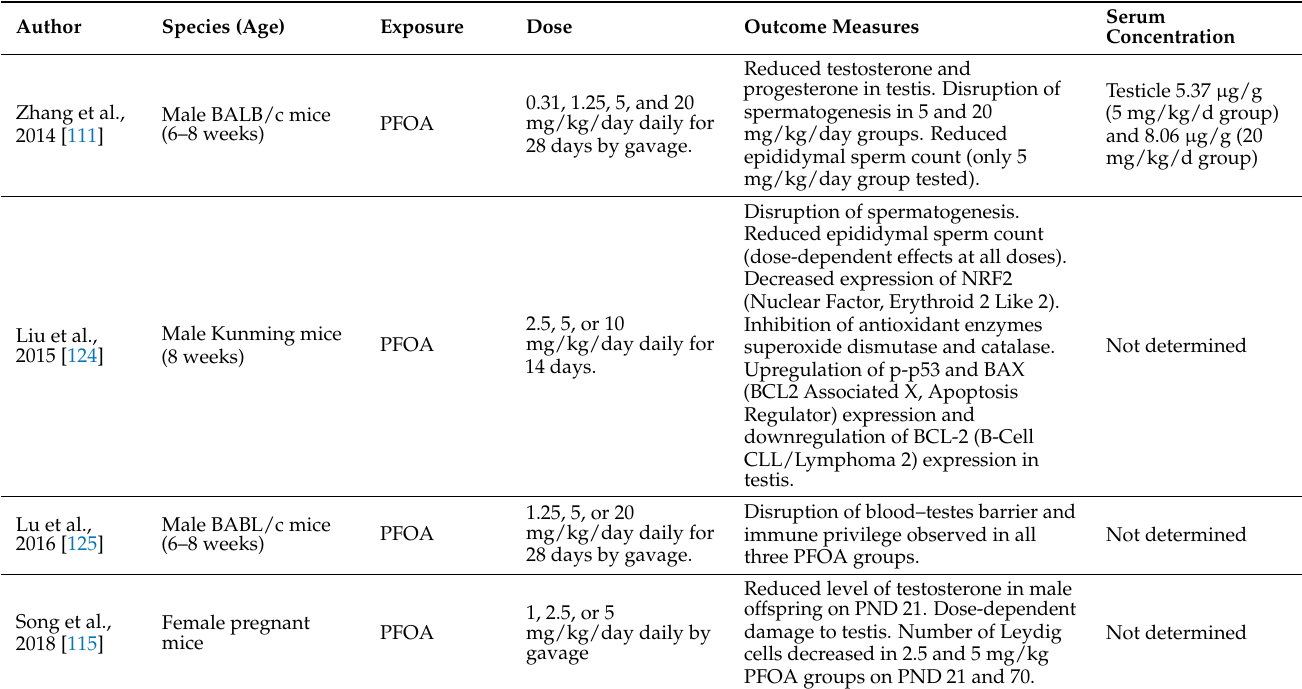
Table 2. PFOA exposure and male fertility measures in mice.